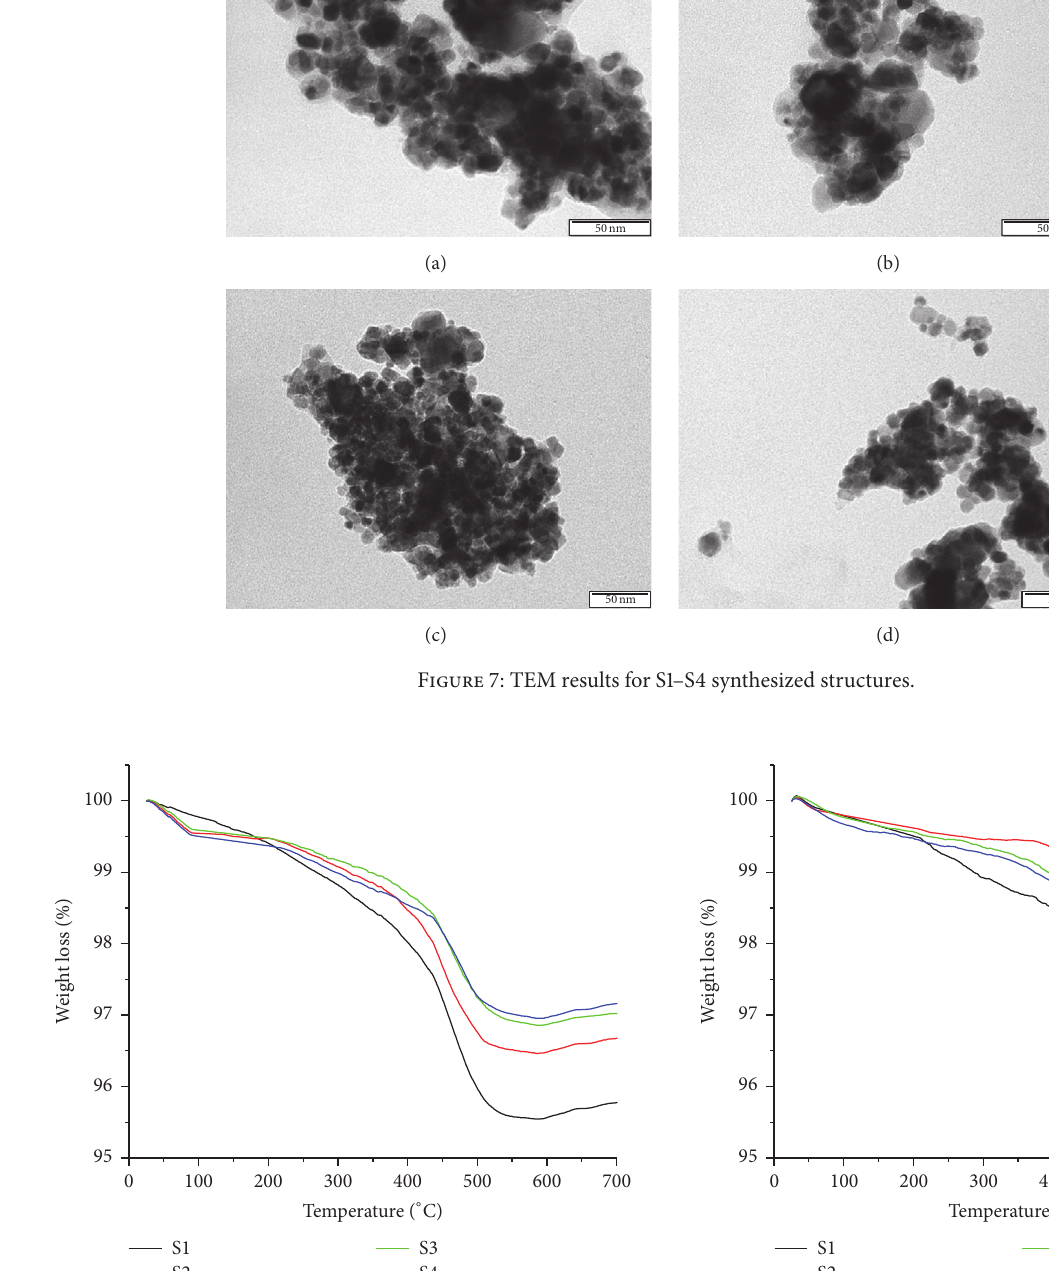
decrease can be observed and mass loss curves indicate the decomposition of organic moiety and SnO 2 crystalline struc- ture modifications. Each sample presents different weight loss over 200 ∘ C, associated especially with the nature of organic acids attached on the SnO 2 surface (Table 1). The second and more intense exothermic peak is related to the thermal decomposition of the organic matter, just as